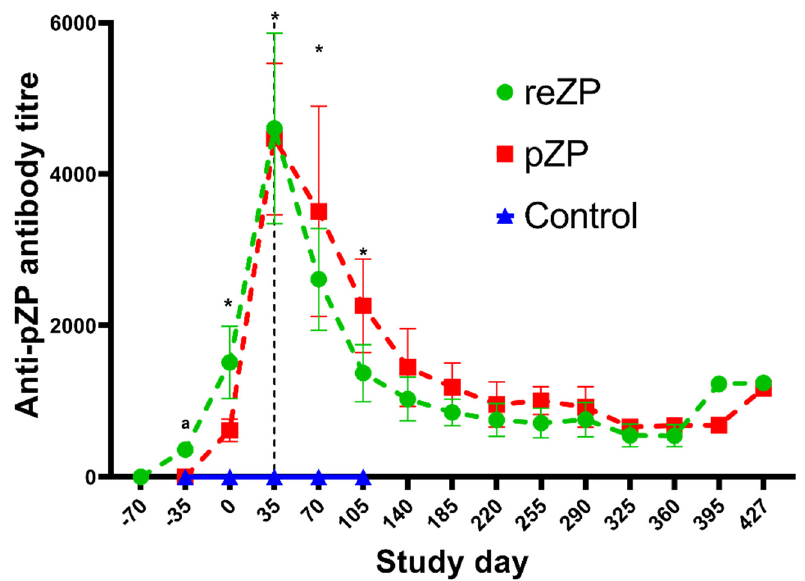
Figure 3. Mean ( ± SEM) anti-pZP antibody titres ( ± standard error) of Control, reZP and pZP treated groups post immunisation with Control, reZP and pZP vaccines, respectively. Day 0 = day of last immunisation. Porcine native zona pellucida vaccine (pZP), recombinant zona pellucida vaccine (reZP), or placebo (Control, just the Poly I:C/PetGel A adjuvant). Jennies were vaccinated with three doses of reZP on Days − 70, − 35 and 0. For both pZP and Control, the primary dose and the booster were administered on Days − 35 and 0. Superscript letter ( a ) denote difference between reZP and Control group, wheres asterisk (*) denotes differences between both treated groups (reZP and pZP) and the Control group ( p < 0.05). Table 2. Anti-pZP antibodies titres at Day 35 in jennies vaccinated with recombinant zona pellucida (reZP), porcine native zona pellucida (pZP) vaccines, or placebo (Control).